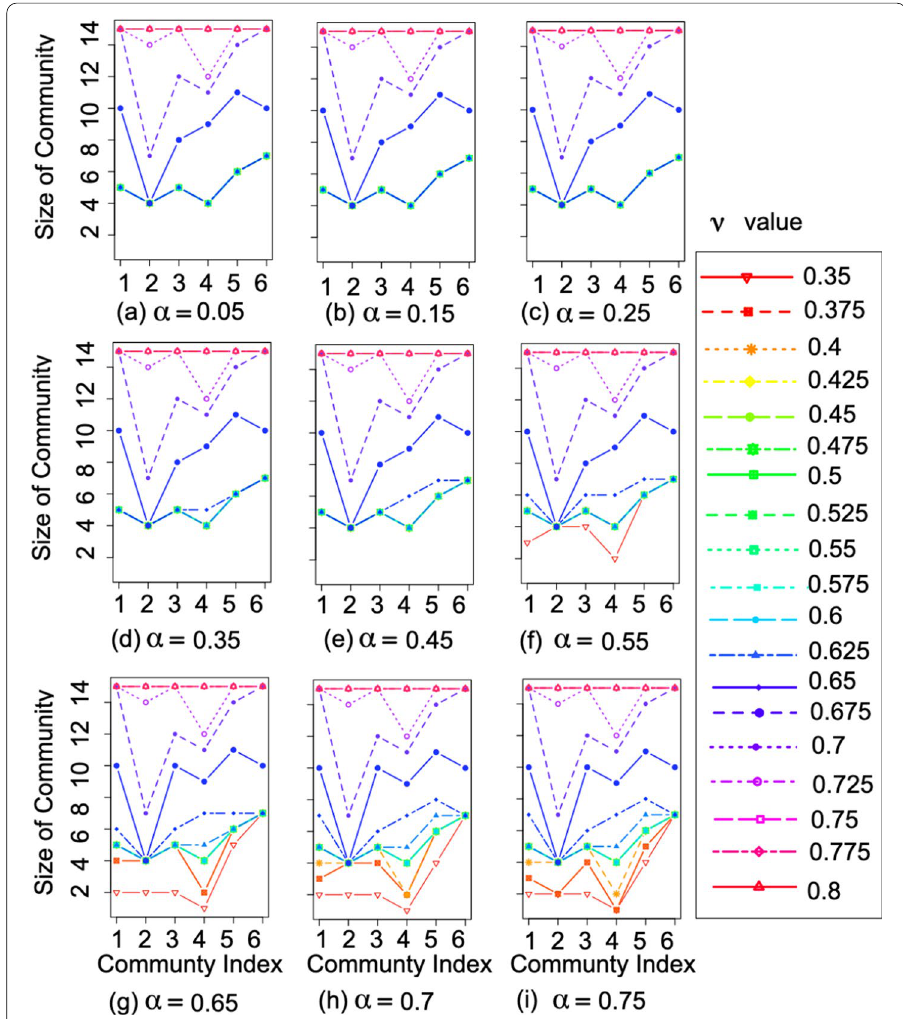
Fig. 5 From the LFR benchmark the statistics of network that we used are N = 15 , k = 3 , maxk = 5 , ν = 0.2 , t 1 = 2 , t 2 = 1 , minc = 3 , maxc = 5 , on = 5 , om = 2 . The value of α is tested for α ∈ [ 0.05,0.8 ] . For each α the ν is tested for ν ∈ [ 0.35,0.8 ] . The initial seed nodes were the same for all the runs. The value of number of communities to be created is the same in all the cases; i.e. nc = 6 . The delta set is same in each cases with ν and α with the values [0.24, 0.55, 0.60, 0.65, 0.70, 0.75, 0.80, 0.85, 0.90,